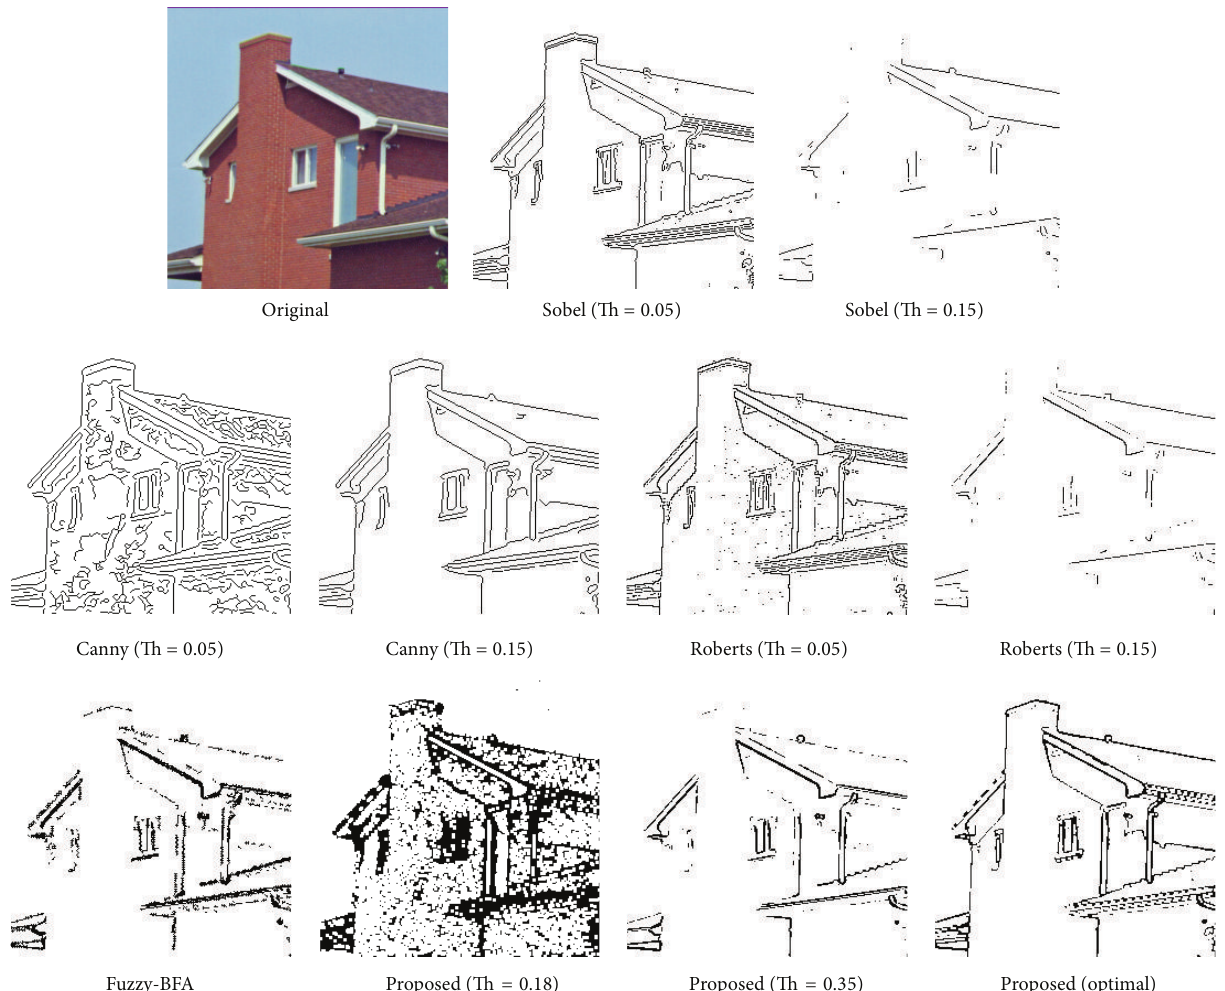
Figure 11: Edge detection results of “house” image: Sobel, Canny’s, and Roberts methods using thresholds = 0.05 and 0.15; fuzzy-BFA method; proposed method with fixed thresholds (0.18 and 0.35) and optimal